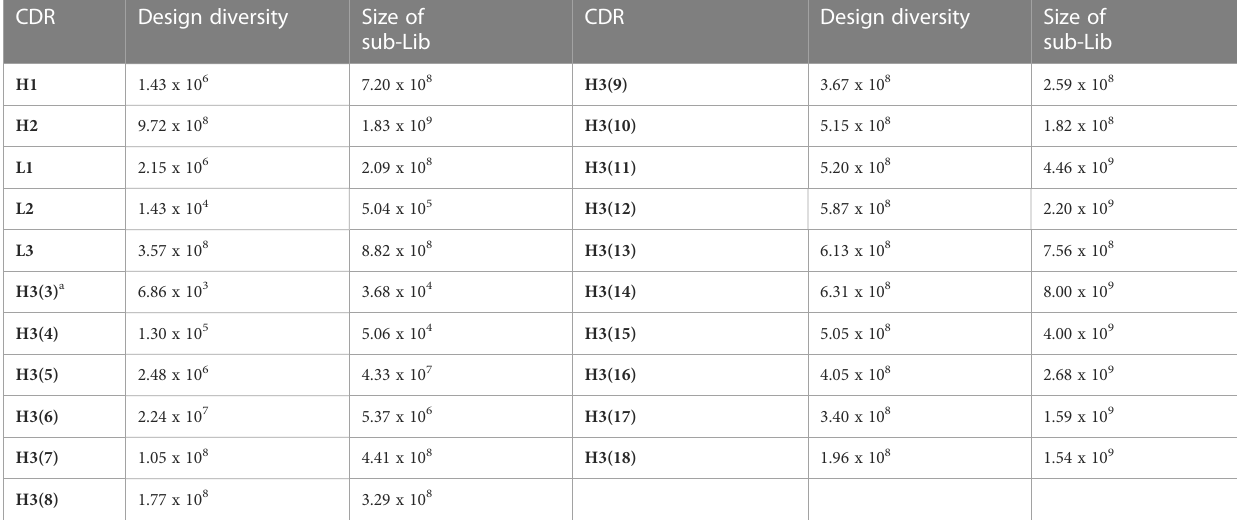
TABLE 1 Summary of in-frame selection results (21 sub-libraries (Lib)).